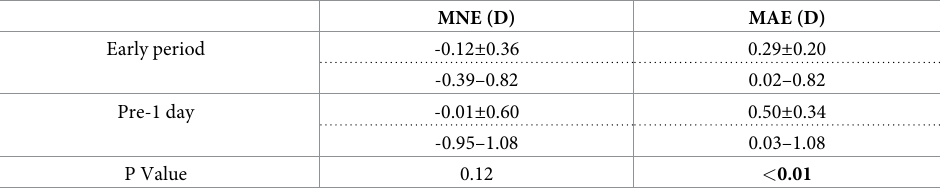
Table 3. Postoperative refractive outcomes.